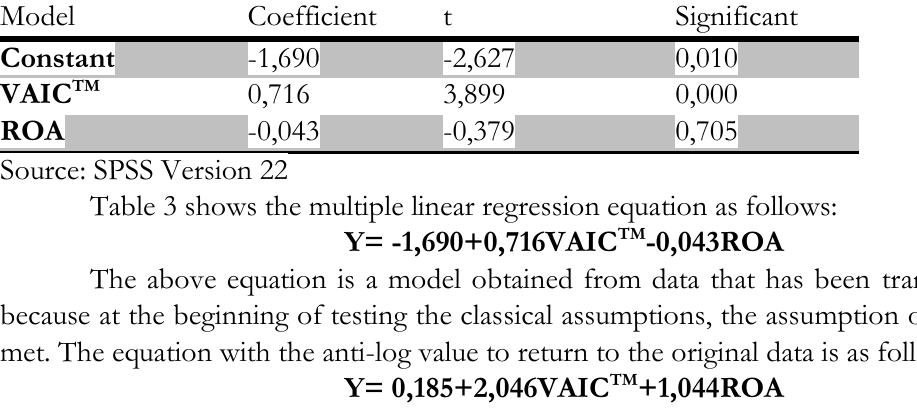
Table 3. Intellectual Capital_IC Regression Model and Financial Performance of